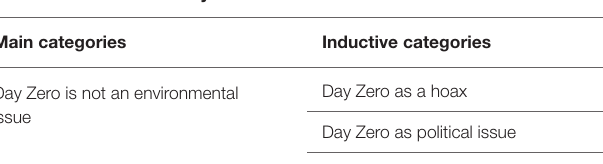
RQ1 - Which interpretative patterns construct the local community’s meaning making processes